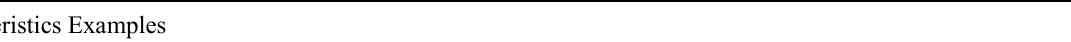
Table 5. Examples of innovation and social